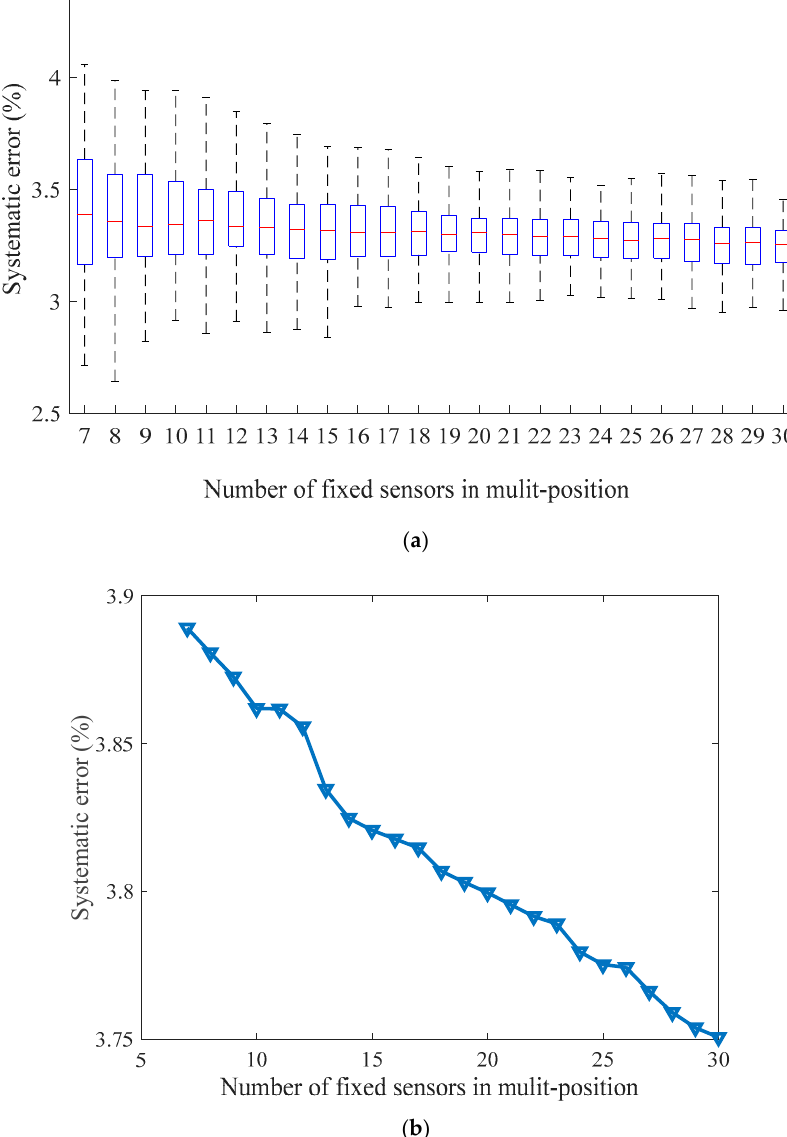
Figure 17. Trustworthiness and average systematic error of Algorithm 2. ( a ) Trustworthiness. ( b ) Average systematic error.